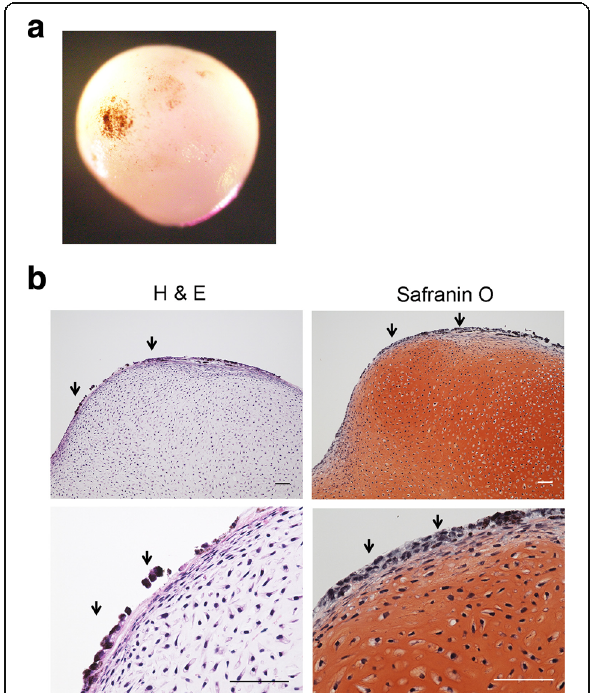
Fig. 2 Aberrant emergence of dark dots on the surface of hiPSC-derived cartilaginous particles. a Image of a hiPSC-derived cartilaginous particle with dark dots at 12 weeks. b Histological analysis of the hiPSC-derived cartilaginous particle in a . Semiserial sections were stained with hematoxylin-eosin and safranin O-fast green-iron hematoxylin. Arrows indicate dark dots. Bars, 50 μ m.